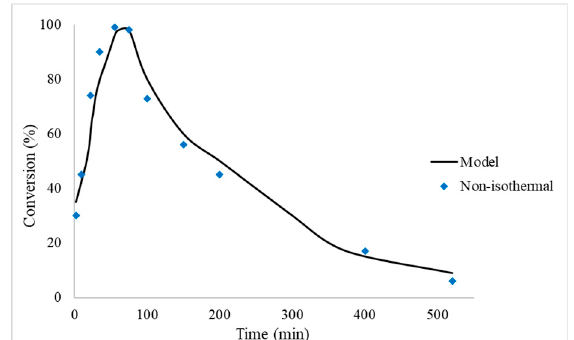
Figure 5. Effect of temperature on the conversion of formic acid. Reaction conditions: pressure = 1 bar; inlet flow = 0.05 mL/min; 0.1 g catalyst of 5 wt.% Pd on Carbon.